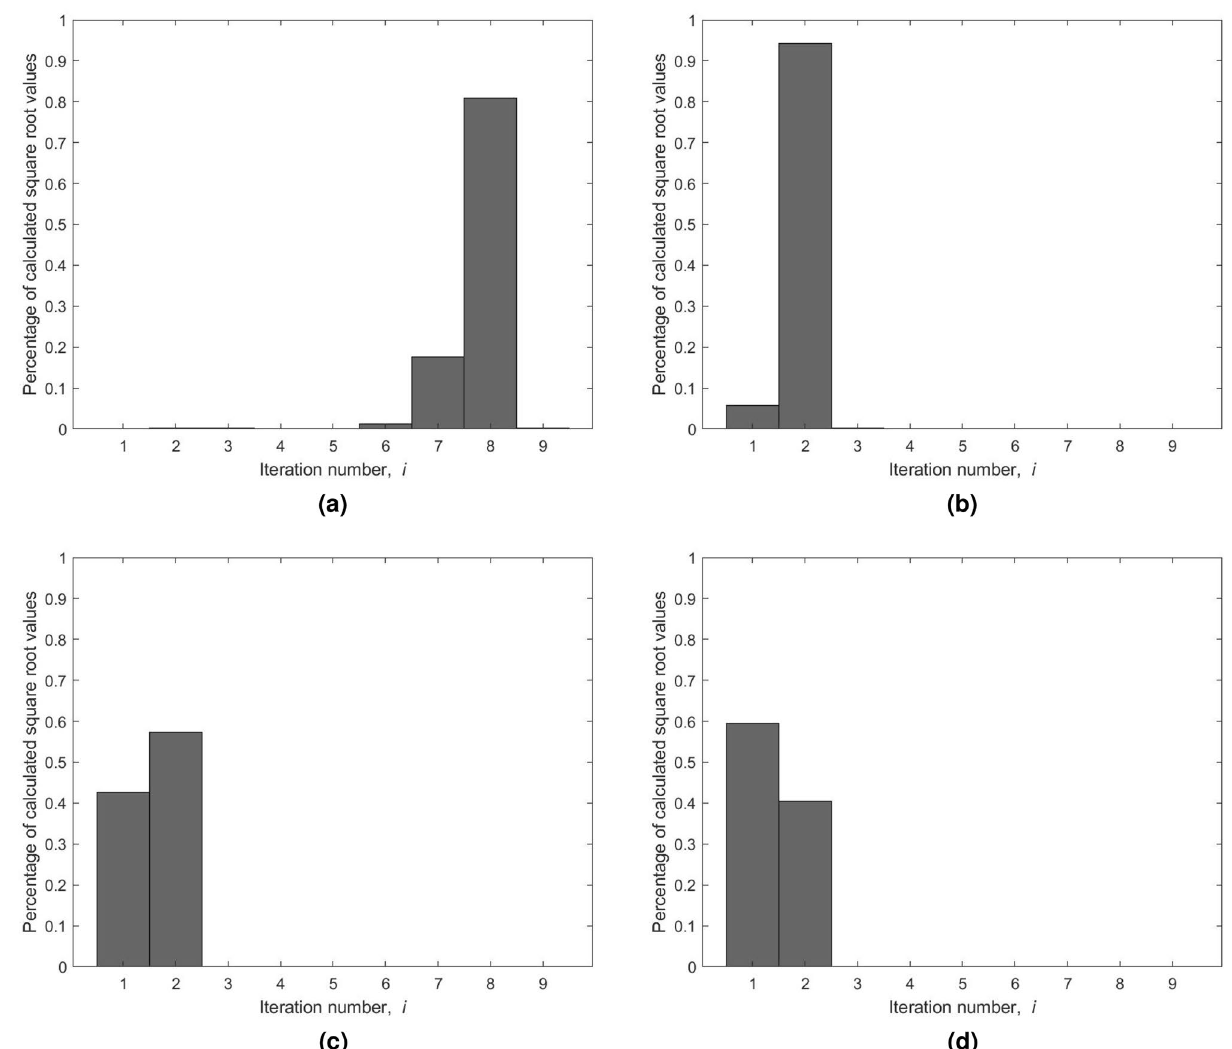
Figure 8. Distribution of the number of iterations of Bakhshali’s method using different seed values: ( a ) Seed is k − 1 equal to x . ( b ) Seed is equal to 3 × 2 . ( c ) Seed using Blinn’s method. ( d ) Seed is obtained using our algorithm based on bit manipulation, s 0 . Seed